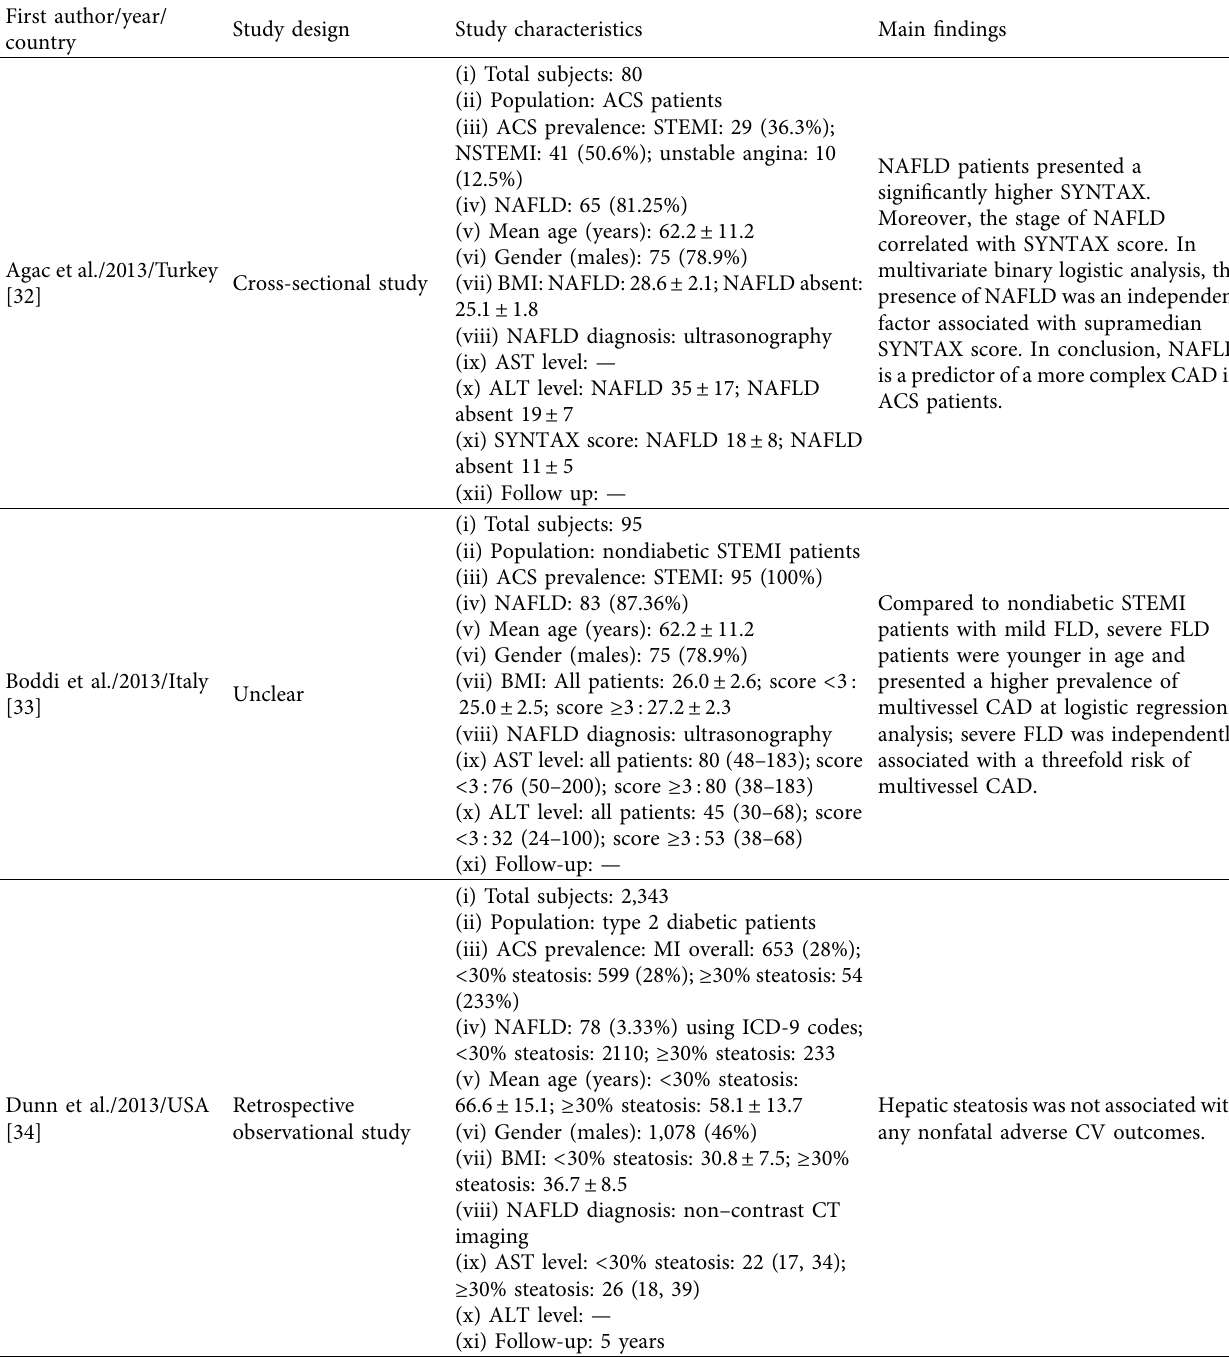
Table 1: Studies assessing the outcomes associated with NAFLD in patients with